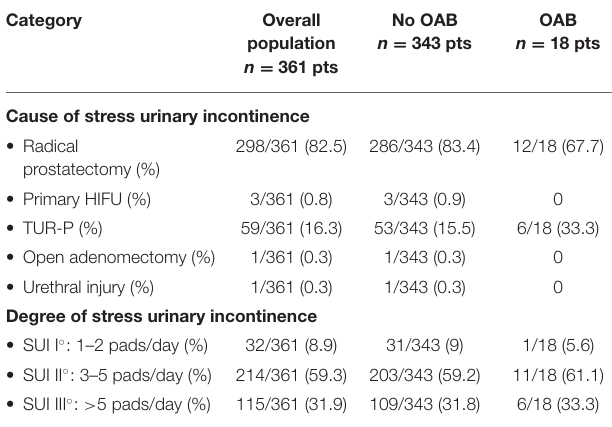
TABLE 1 | Baseline characteristics of the patient population ( n = 361 patients);